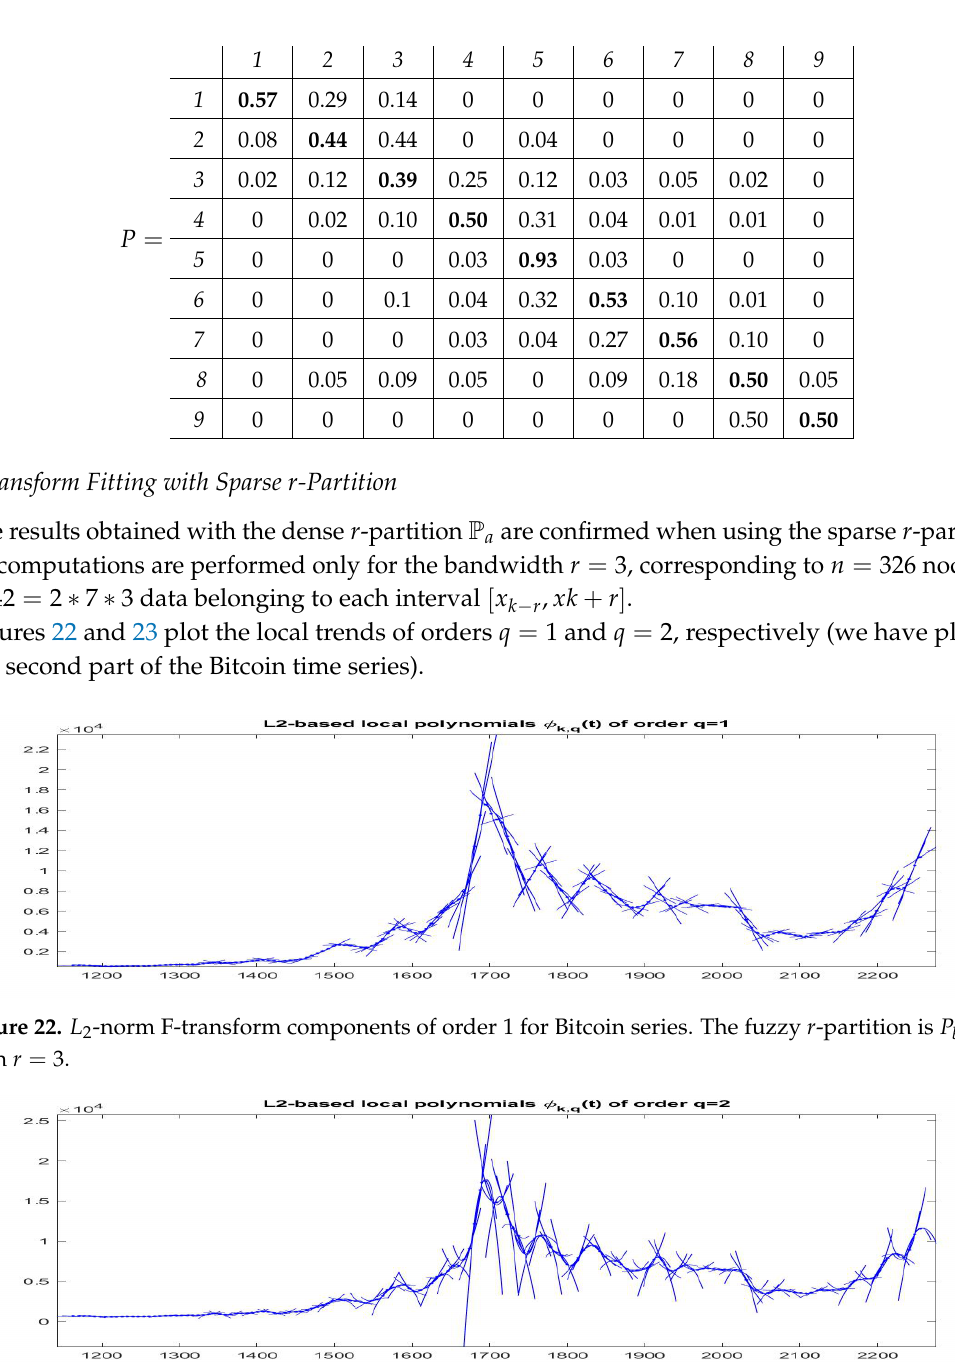
Figure 23. L 2 -norm F-transform components of order 2 for Bitcoin series. The fuzzy r -partition is P b with r =